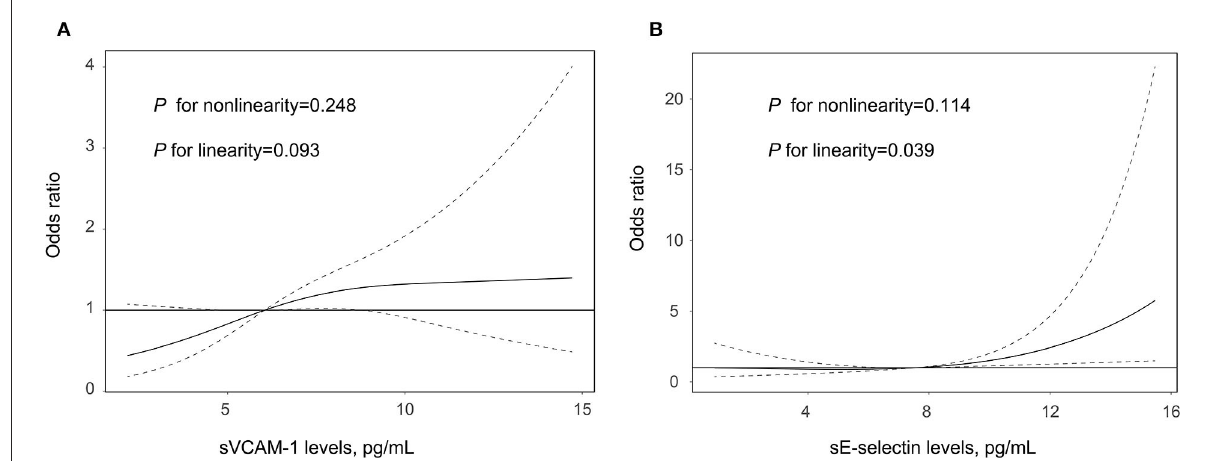
FIGURE1 Association of sVCAM-1 (A) and sE-selectin (B) with the risk of poor outcome after acute ischemic stroke treated by endovascular treatment. Association was fitted with restricted cubic spline with 3 knots (at 5th, 50th, and 95th percentiles) adjusting for covariates with a p- value < 0.1 in the univariate analysis. The midpoint of sVCAM-1 and sE-selectin levels were set as the reference point. The solid line represents the odds ratio ( OR ) and the dashed lines represent the 95% confidence interval ( CI ). sE-selectin, soluble E-selectin; and sVCAM-1, soluble vascular cell adhesion molecule-1.